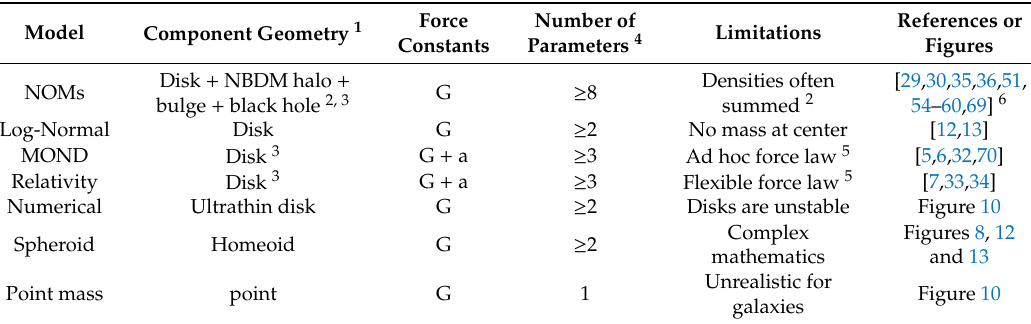
Table 2. Forward Models Applied to Rotation